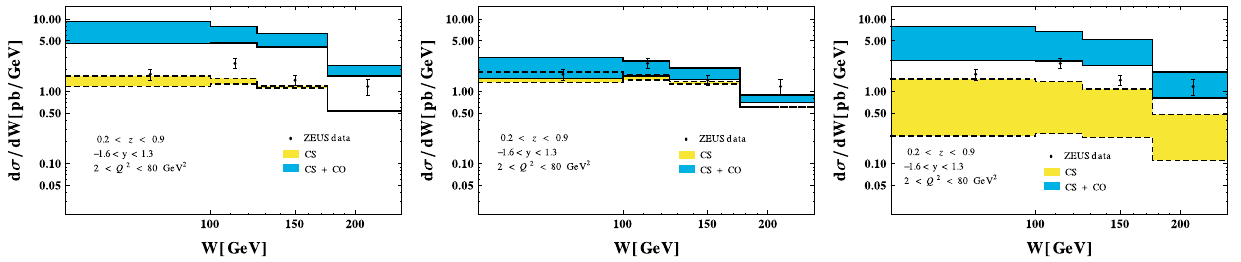
Fig. 10 The differential cross sections for the J /ψ production in DIS with respect to W . The experimental data are taken from Ref. [51]. The l.h.s., middle, and r.h.s. plots correspond to the LDMEs taken in Refs. [28,30,41], respectively